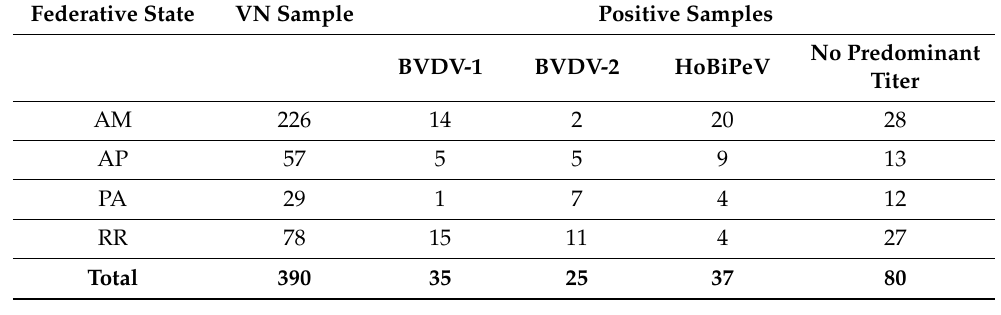
Table 2. Number of samples for which the species that raised the antibodies could be determined (BVDV-1, 2 and HoBiPeV) or not, by federative state.